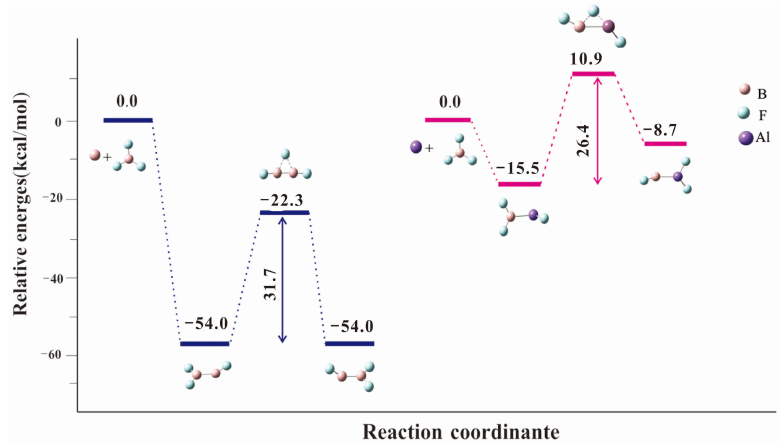
Figure 5. Potential energy surface of group 13 atoms (B and Al) and BF 3 reaction products calculated at CCSD (T)/def2-TZVPP level. Energies were given in kcal/mol. The bond angle of B-B-F for the F 2 B-BF molecule is 142 ◦ , which is quite different from the 116 ◦ of B-Al-F angle for F 2 B-AlF (Figure 4). As shown in Figure 6a, for the F 2 BBF molecule, the B = B bond is composed of one σ bond with an occupation of 1.94 e and one (p-p) π bond with an occupation of 1.00 e in the plane, which leads to a larger B-B-F bond angle. The effective bond order (EBO) of B-B bond is 1.32 calculated by natural bond orbital (NBO) population analysis. The calculated 1.644 Å of B = B bond length is shorter than that of B-B single bond between 1.819 and 1.859 Å, but longer than 1.561 and 1.590 Å of the B = B double bond length in R(H)B = B(H)R (R = :C{N(2,6- Pri 2 C 6 H 3 )CH} 2 ) [17], and in OC(H)B = B(H)CO [18], respectively, affirming that B-B bond order in F 2 B-BF is between one and two. Notice that for the F 2 BAlF molecule, the effective bond order (EBO) of B-Al is 0.96 with an occupation of 1.93 e in the σ character (Figure 6b). The Al atom possesses a single electron (mostly from the s orbital) which does not participate in bonding. Although B and Al atom are in the same group, their bonding situation is very different. As shown in Table S1, for the F 2 BBF molecule, both boron atoms have a good hybridization with the s and p orbital, while little hybridization occurs between the s and p orbital for the B-Al σ bond in the F 2 BAlF